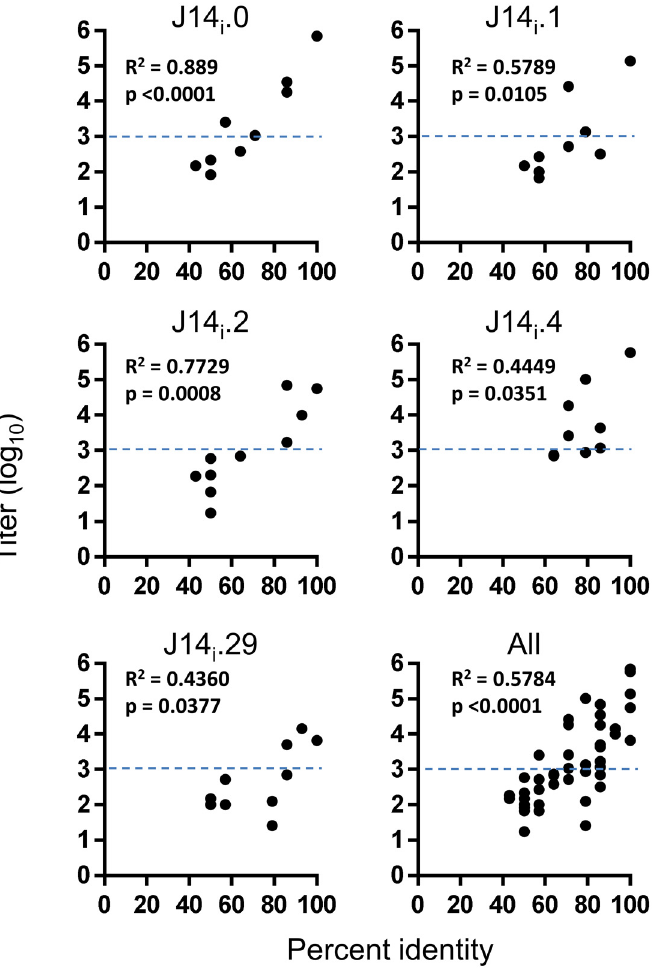
Fig 3. Correlation between antibody titer and peptide identity. The ELISA titer for each J14 i peptide antisera/peptide combination is plotted against the percent identity of the two corresponding peptides. Percent identity is plotted on the x-axis. Corresponding titers are plotted on the y-axis. Linear regression revealed that a significant correlation between these two variables exists for each antisera. The dotted horizontal line shows the cut-off used as the titre used to differentiate between low or non-significant binding, and significant